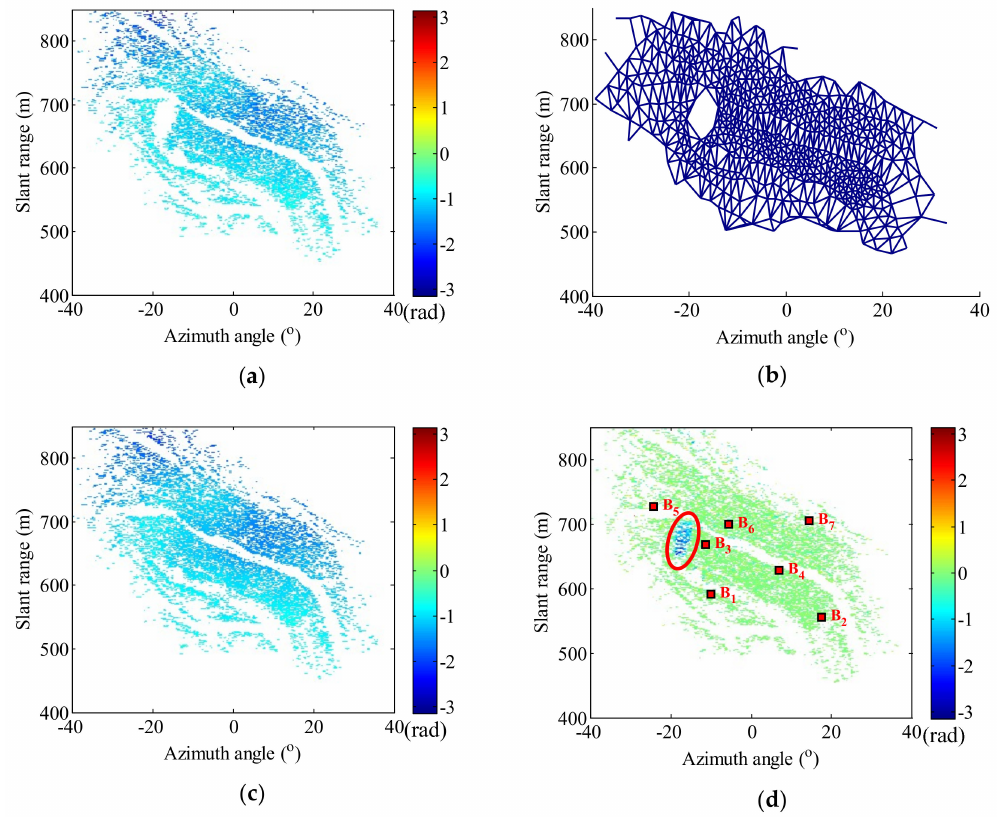
( 30 ) of Group B. ( a ) Phase map of the atmospheric B